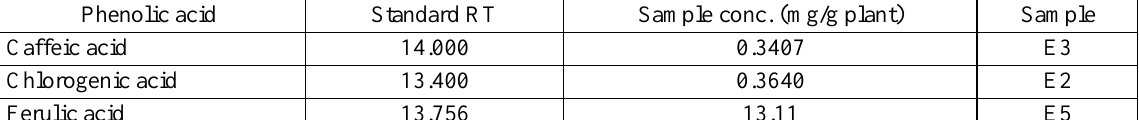
Figure 8 .HPTLC plates for standards and sample phenolic acids in E2, E3 and E5 at 254nm (above) and 366nm (below). Caf= caffeic acid, Chl= chlorogenic acid, Fer= ferulic acid, samples E1 to E5. Table 3. Retention times of the standard phenolic acids and the concentration of sample phenolic acids at standard retention time.